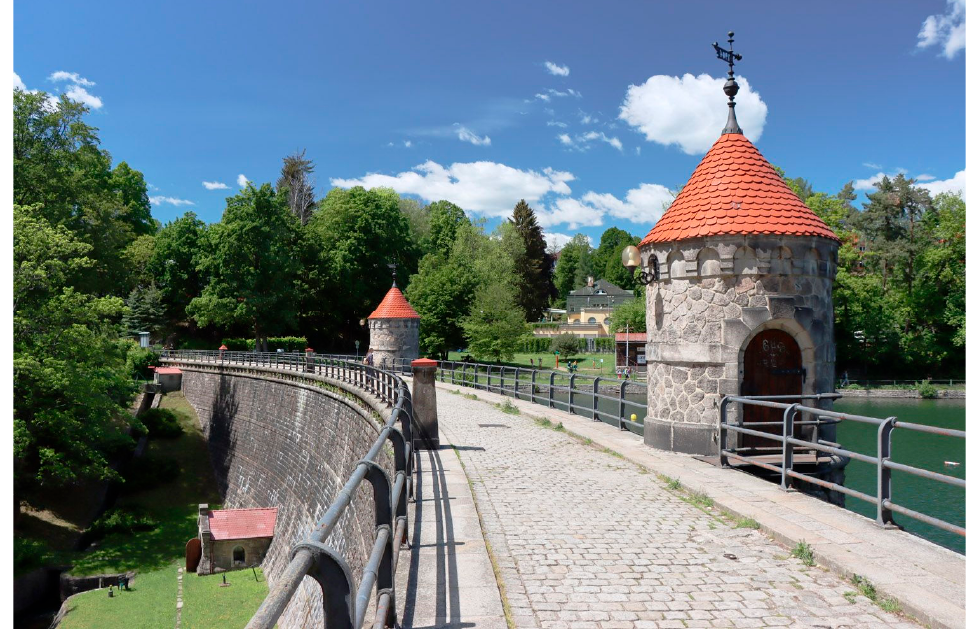
Figure 4. Harcov Dam, built of Liberec granite and other types of local granite. Photo by author.